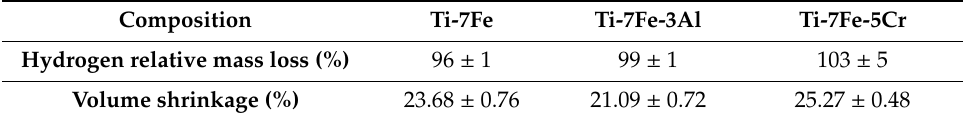
Table 3. Hydrogen mass loss and volume shrinkage from sintering process